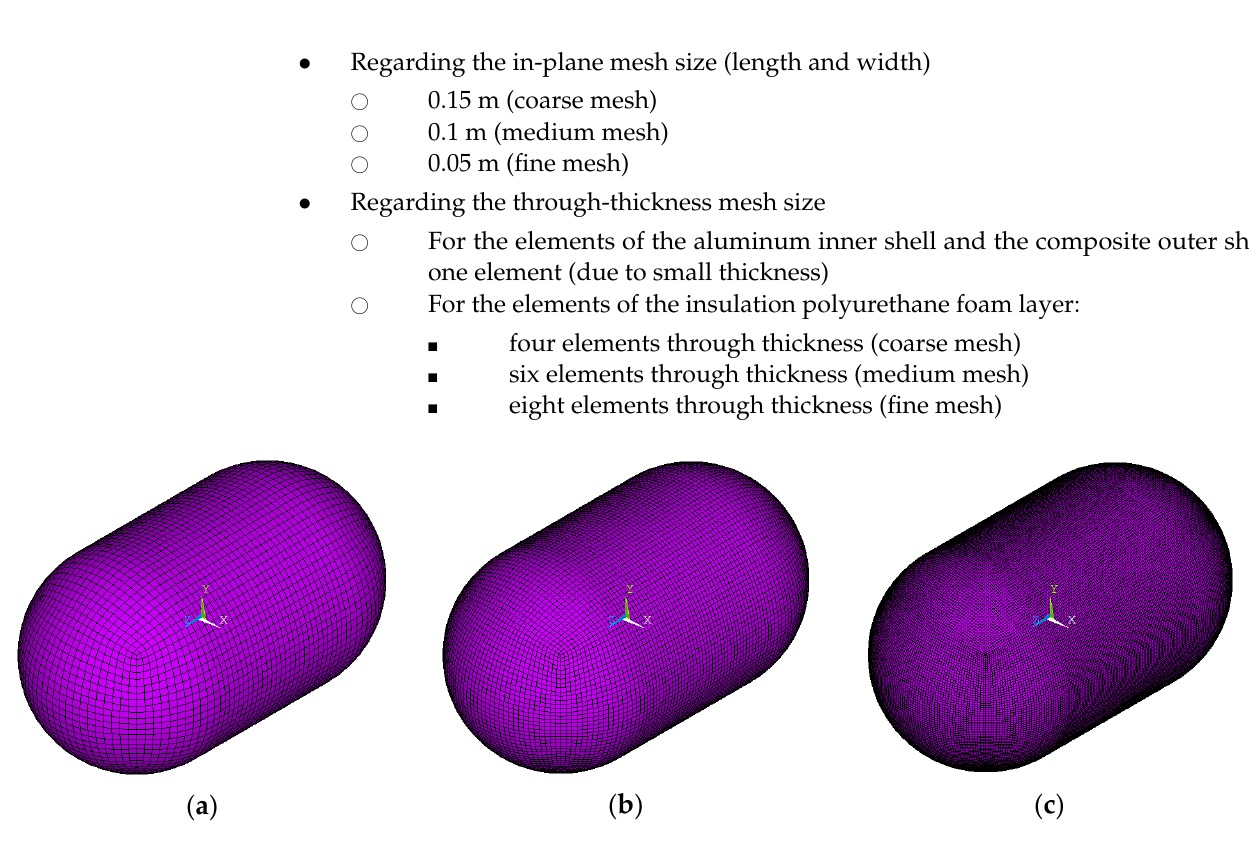
Figure 3. Representation of the tank configuration on which the convergence analysis is performed.